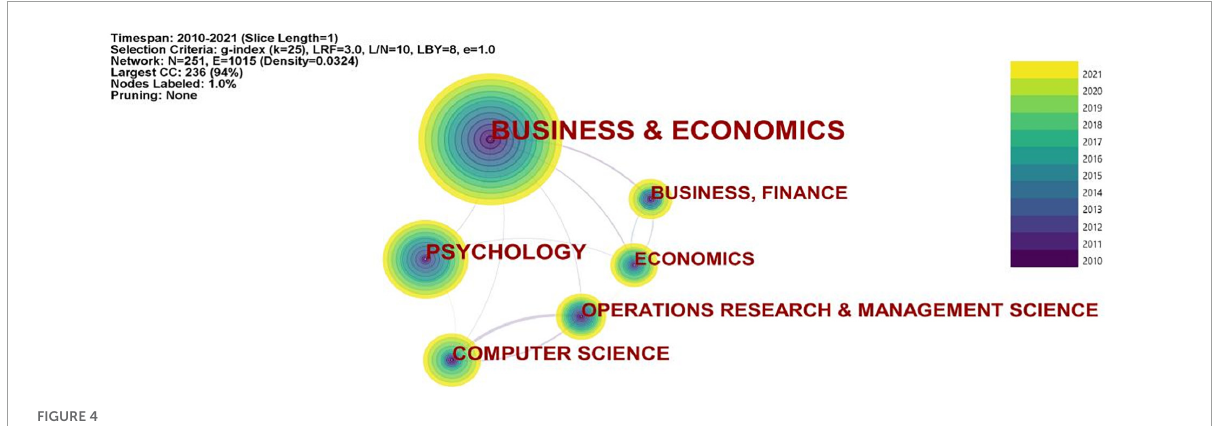
FIGURE4 The most highly co-occurring categories.